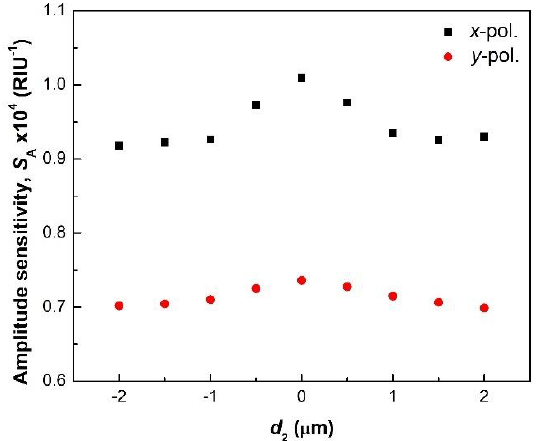
Figure 10. Amplitude sensitivity as a function of d 2 . Black points (square shape) and red points